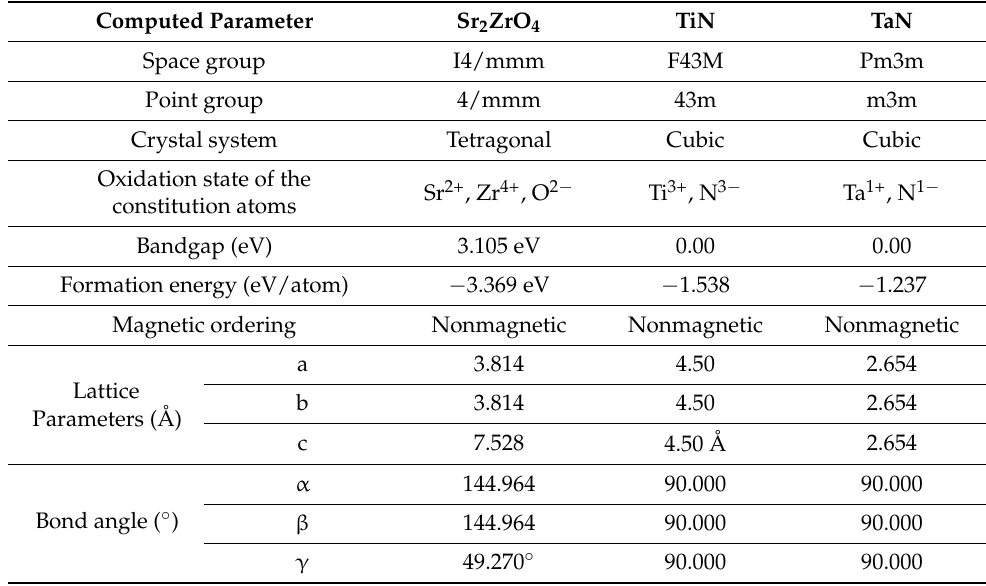
Table 1. Equilibrium structural parameters of Sr 2 ZrO 4 , TiN and